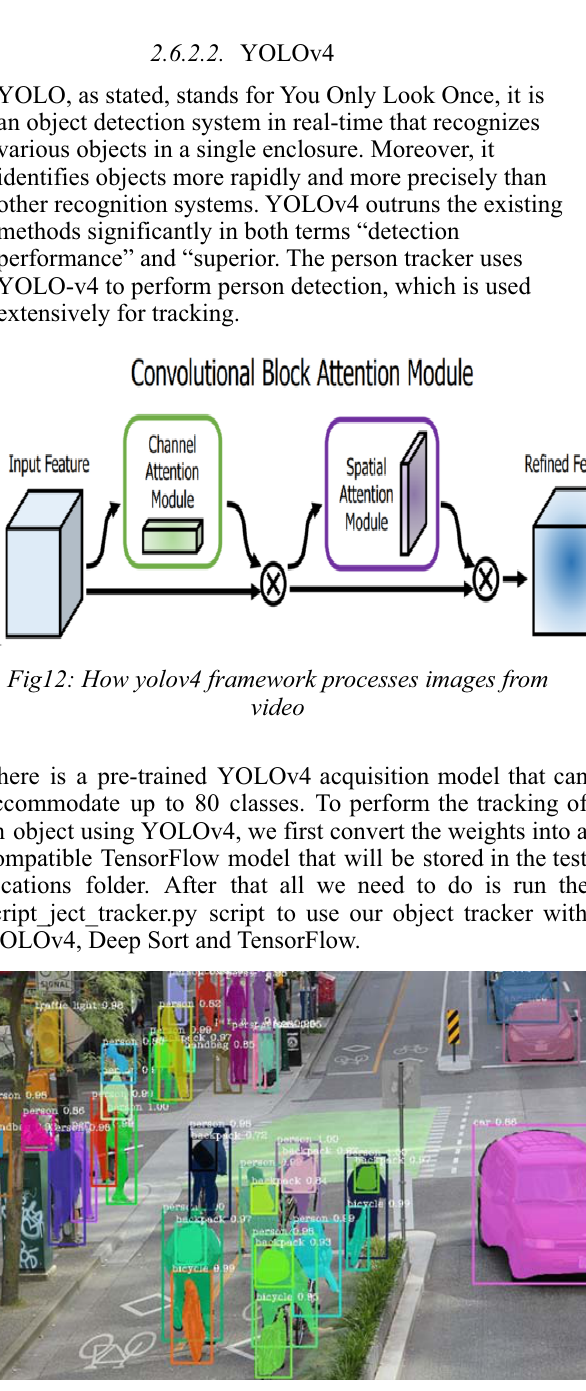
Fig13: creating bounding boxes around the humans in the